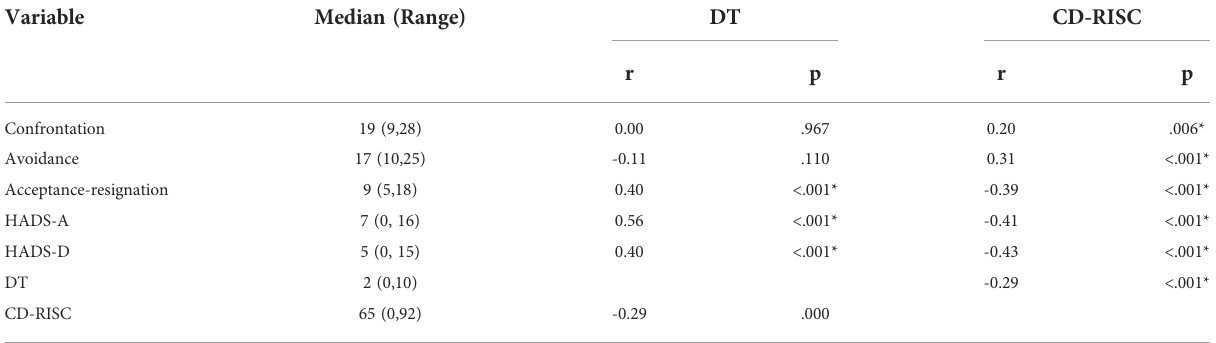
TABLE 2 Relationships between distress, resilience and coping strategies, depression, and anxiety.